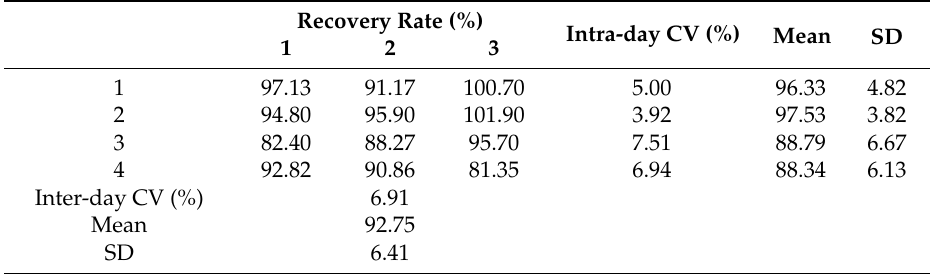
Table 1. The recovery rate in the final rhKGF-1 sample.